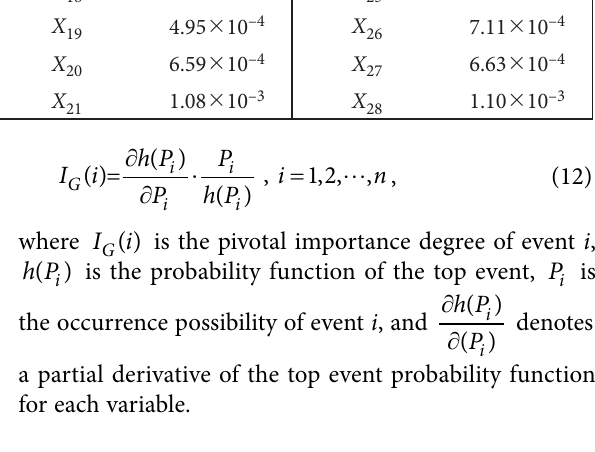
Table 6. Pivotal importance degrees and average